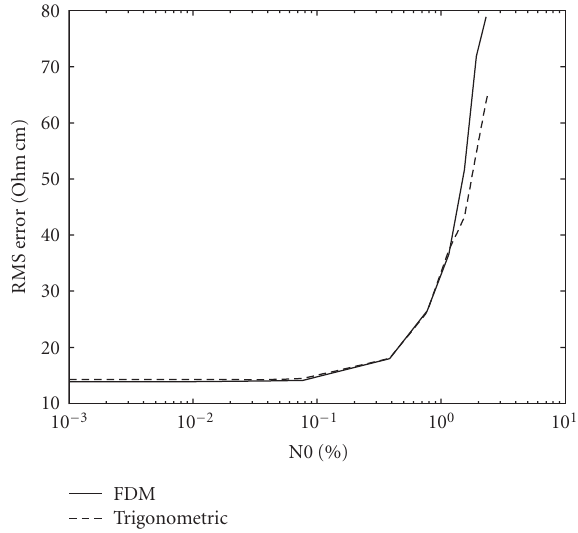
Figure 9: Performance of the FDM and trigonometric current pat- terns for di ff erent noise levels tainting the voltage measurements.